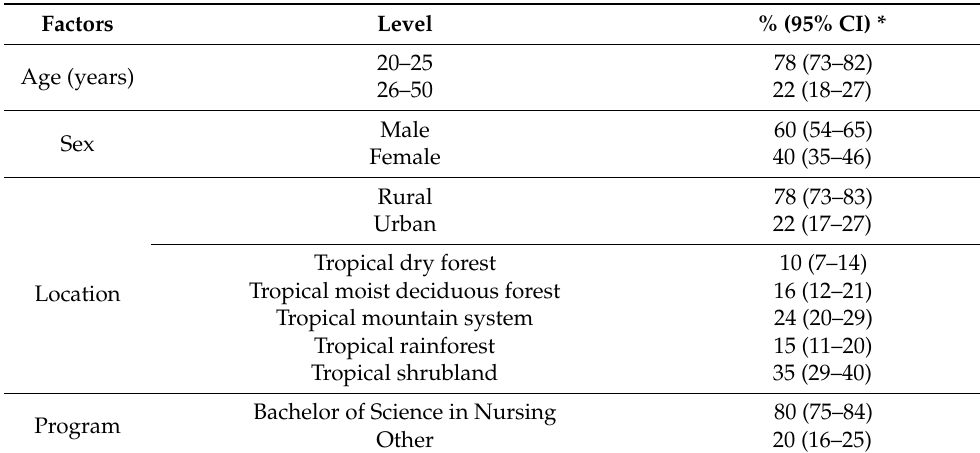
Table 1. Demographic characteristics of the